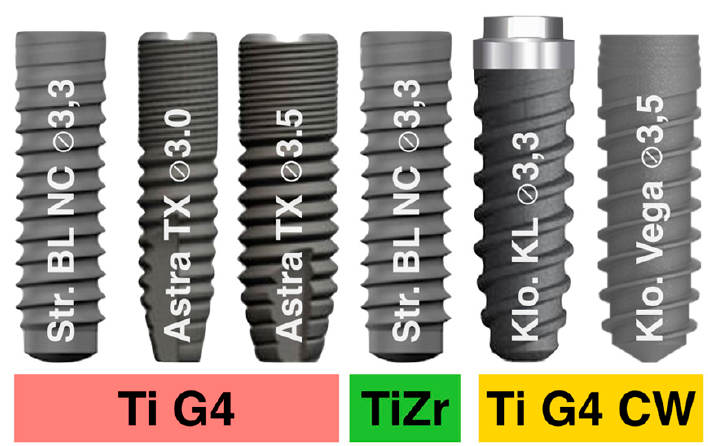
Figure 1. Narrow Dental Implants used in this in vitro study.